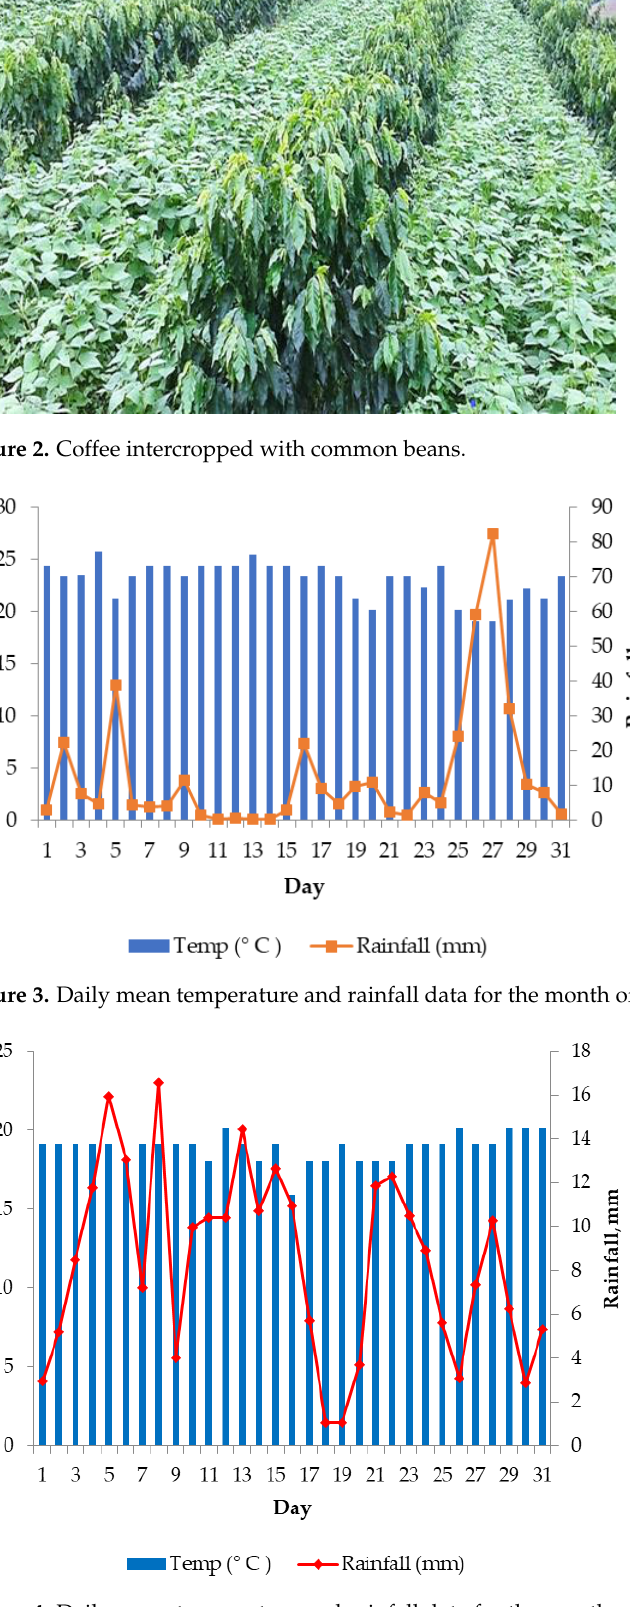
Figure 4. Daily mean temperature and rainfall data for the month of July, 2021.